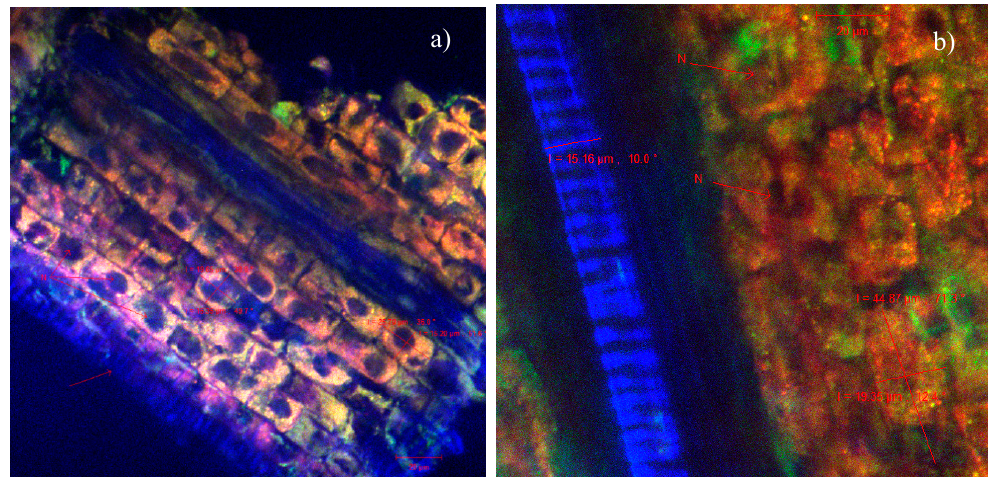
Figure 9. CLSM images of the Triticum estivum L. sprout sections of the indolizine 4c treated samples at two different concentrations: ( a ) 10 − 3 M, ( b ) 10 − 4 M.